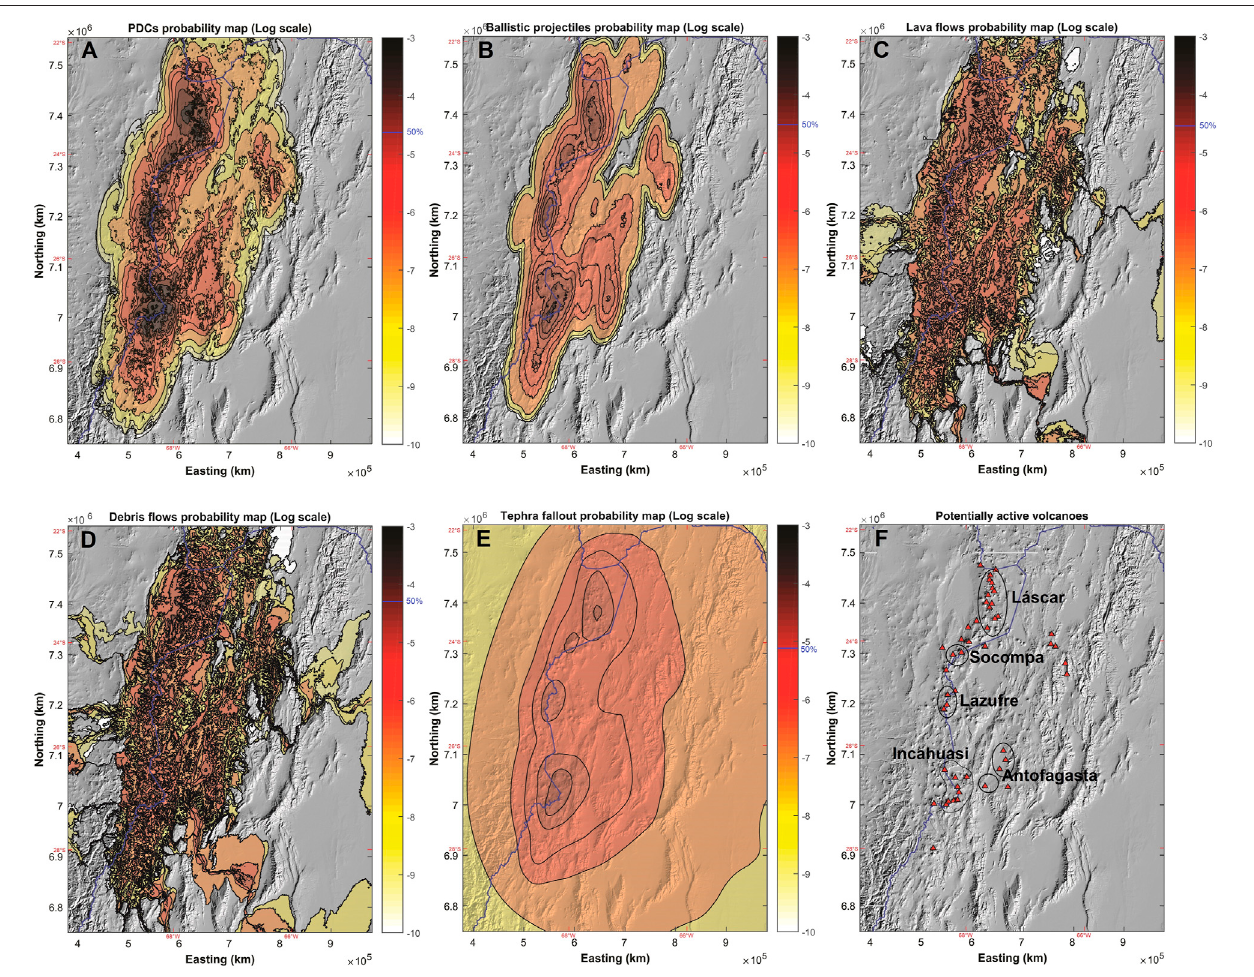
FIGURE 6 | Probabilistic volcanic hazard maps for the Central Volcanic Zone of Chile and Argentina (~22.5 – 28 ° S), obtained after empirical, semi-empirical or analytical modeling of: (A) Pyroclastic density currents, (B) Ballistic projectiles (which encompass near-vent hazards), (C) Lava fl ows, (D) Debris fl ows, and (E) Tephra fallout, basedonthespatio-temporalprobabilityassessmentforaforecasting time intervalof10,000 years.Legend showstheprobabilityofa1 km 2 areabeaffectedby a given volcanic phenomenon during the next 10 kyr, shown as probability isocontours on a logarithmic scale to illustrate order-of-magnitude changes. Light blue horizontal lines drawn in each legend depict the 50% boundary, which means that if a given volcanic phenomenon occurs somewhere, there is a 50% probability it will affect the area enclosed by that boundary. (F) Depicts the Pleistocene-Holocene volcanoes of Figure 2 as well as the approximate boundary of each volcanic cluster, based on Figure 3B , which can be used as a spatial reference. The political border between Chile, Argentina and Bolivia is depicted for reference (blue line). ASTER Digital elevation model used as a background image follows a greyscale colour scheme: the whiter the pixel, the higher the elevation.